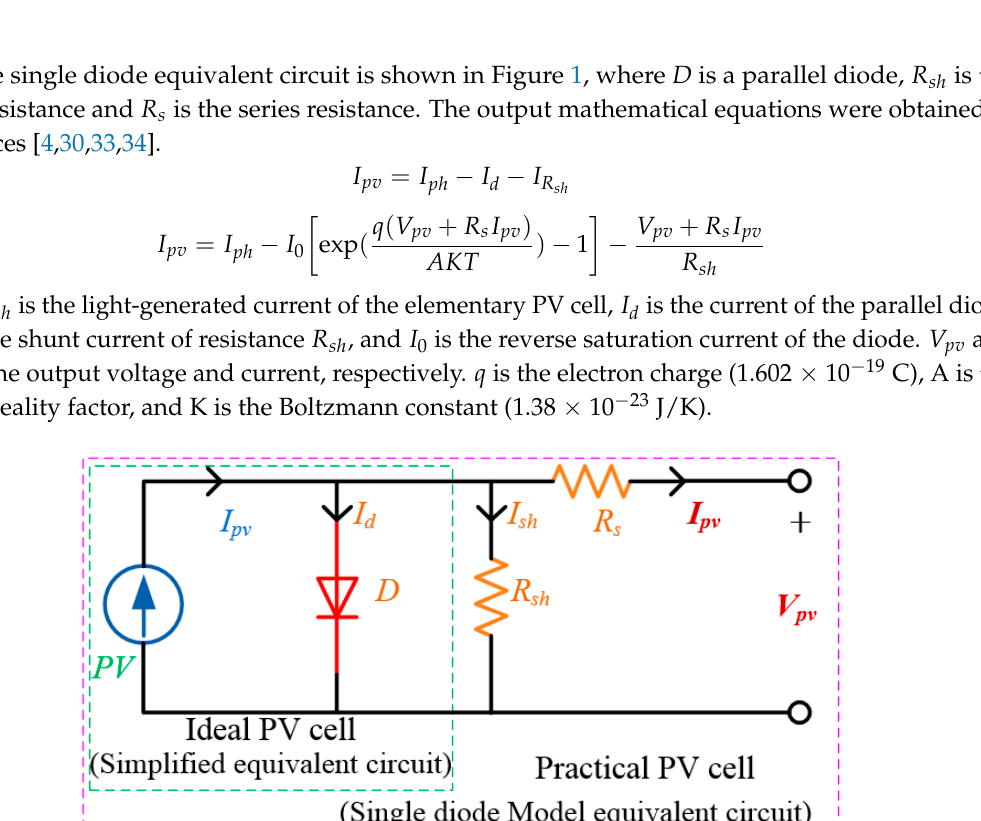
drawn as a current versus voltage ( Ipv-Vpv ) curve and a power versus voltage ( Ppv-Vpv ) curve under different environmental conditions [29].